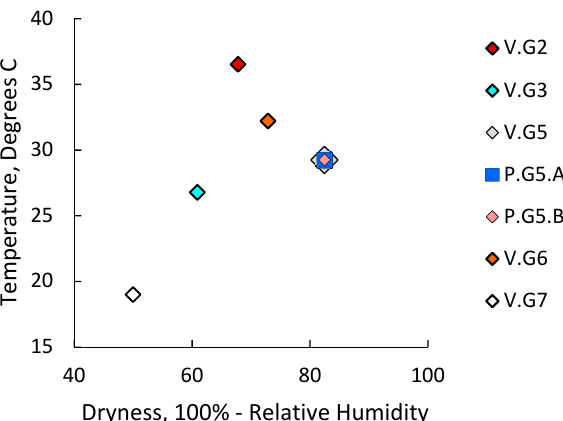
Figure 1. Experimental group exposures to ambient dryness and high temperature. Values presented for groups V.G2, V.G3, V.G5, P.G5, and V.G6 are average daily high temperatures and average daily